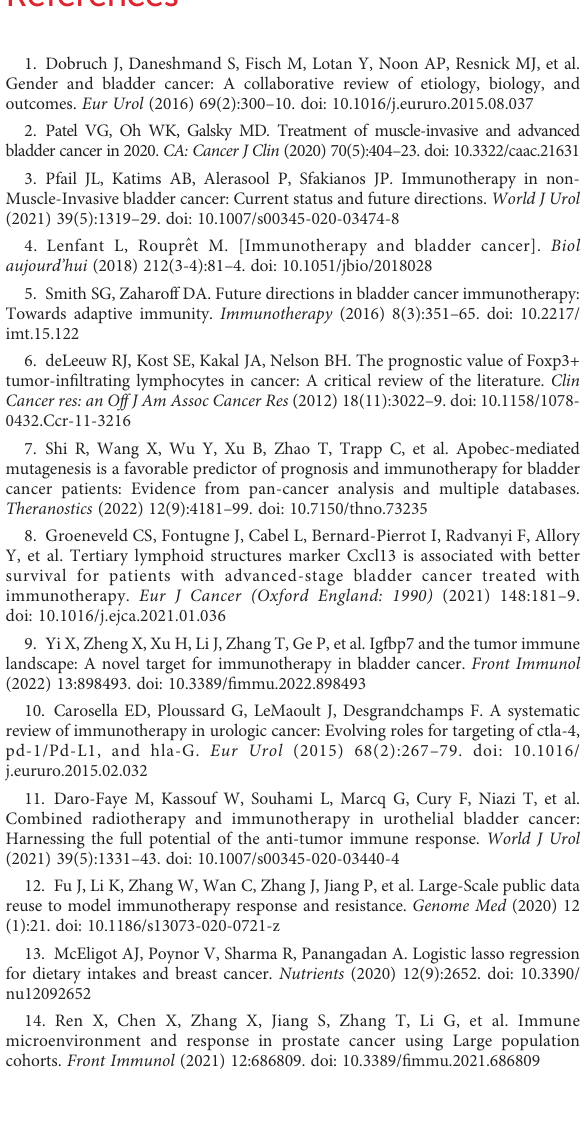
SUPPLEMENTARY FIGURE 4 Prognostic role of PTHLH, BHMT2, and NGFR (A – C) Kaplan – Meier survival curves of PTHLH, BHMT2, and NGFR in overall survival. (D – F) Kaplan – Meier survival curves of PTHLH, BHMT2, and NGFR in disease- free survival. (G – I) Kaplan – Meier survival curves of PTHLH, BHMT2, and NGFR in disease-free survival.